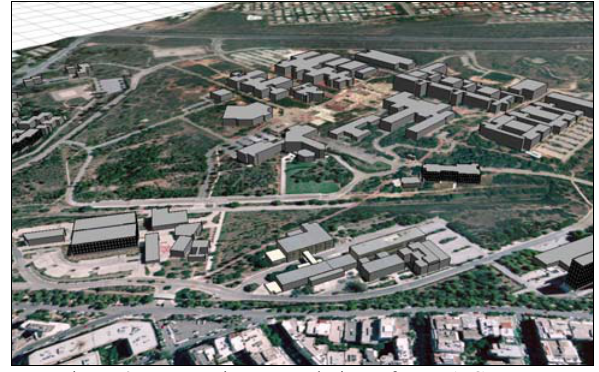
Figure 2. Perspective general view of NTUA Campus